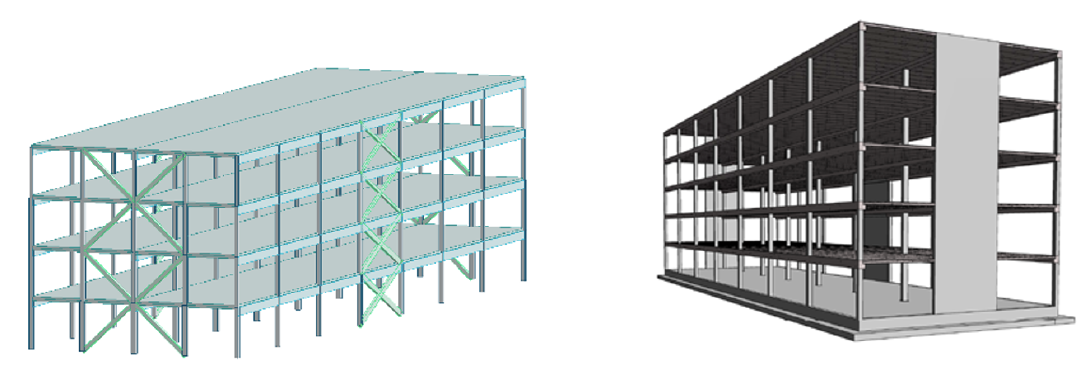
Figure 1. Illustration of the two di ff erent load-bearing structures for o ffi ce buildings (wood-based structure to the